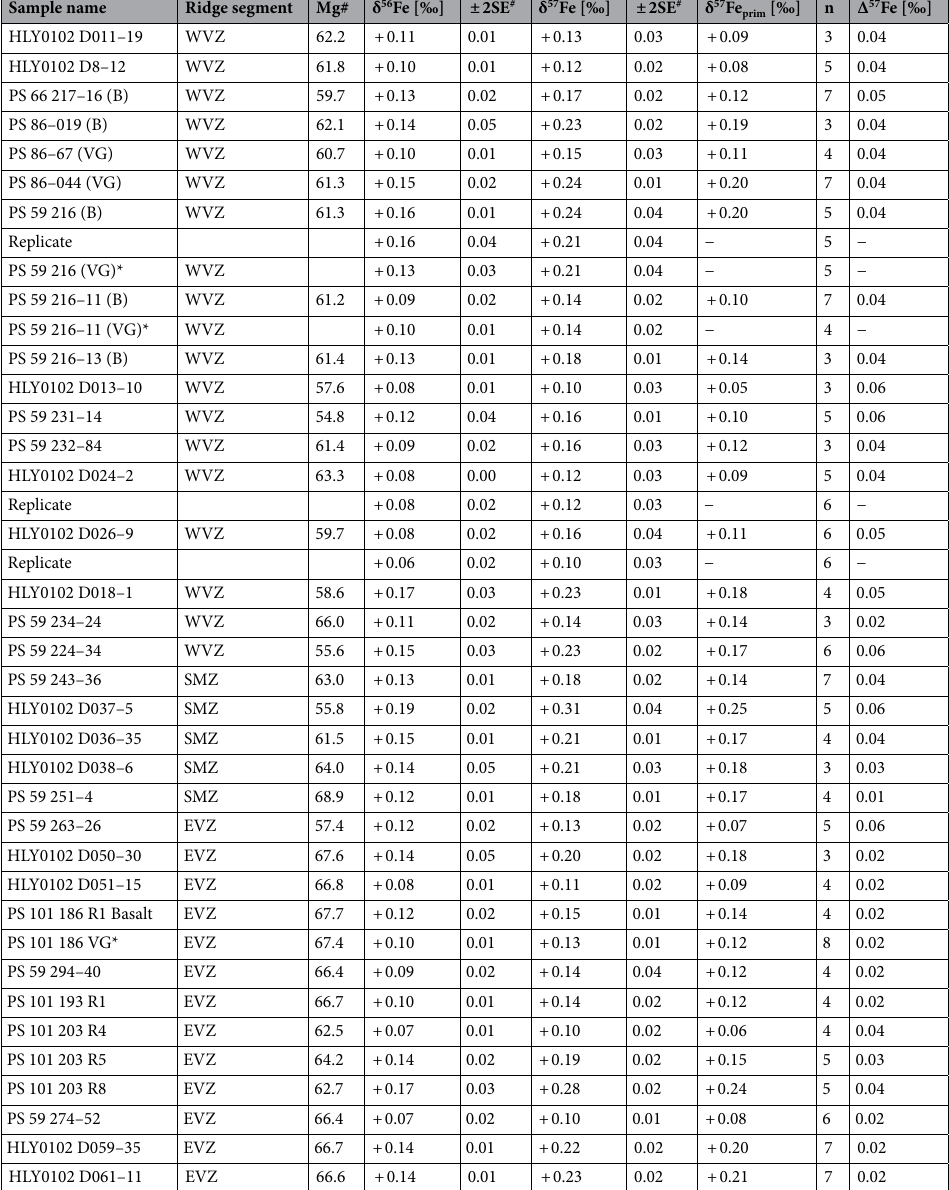
Table 1. Iron isotope data of the Gakkel Ridge basalts (whole rock) and volcanic glasses (VG) relative to IRMM-524A reference material. n = number of analyses; *VG-volcanic glasses, which are treated as sample replicates, because the VG and basalts are from the same rock sample. # Uncertainty is given as two standard error calculated from the number of analyses and the Student’s t correcting